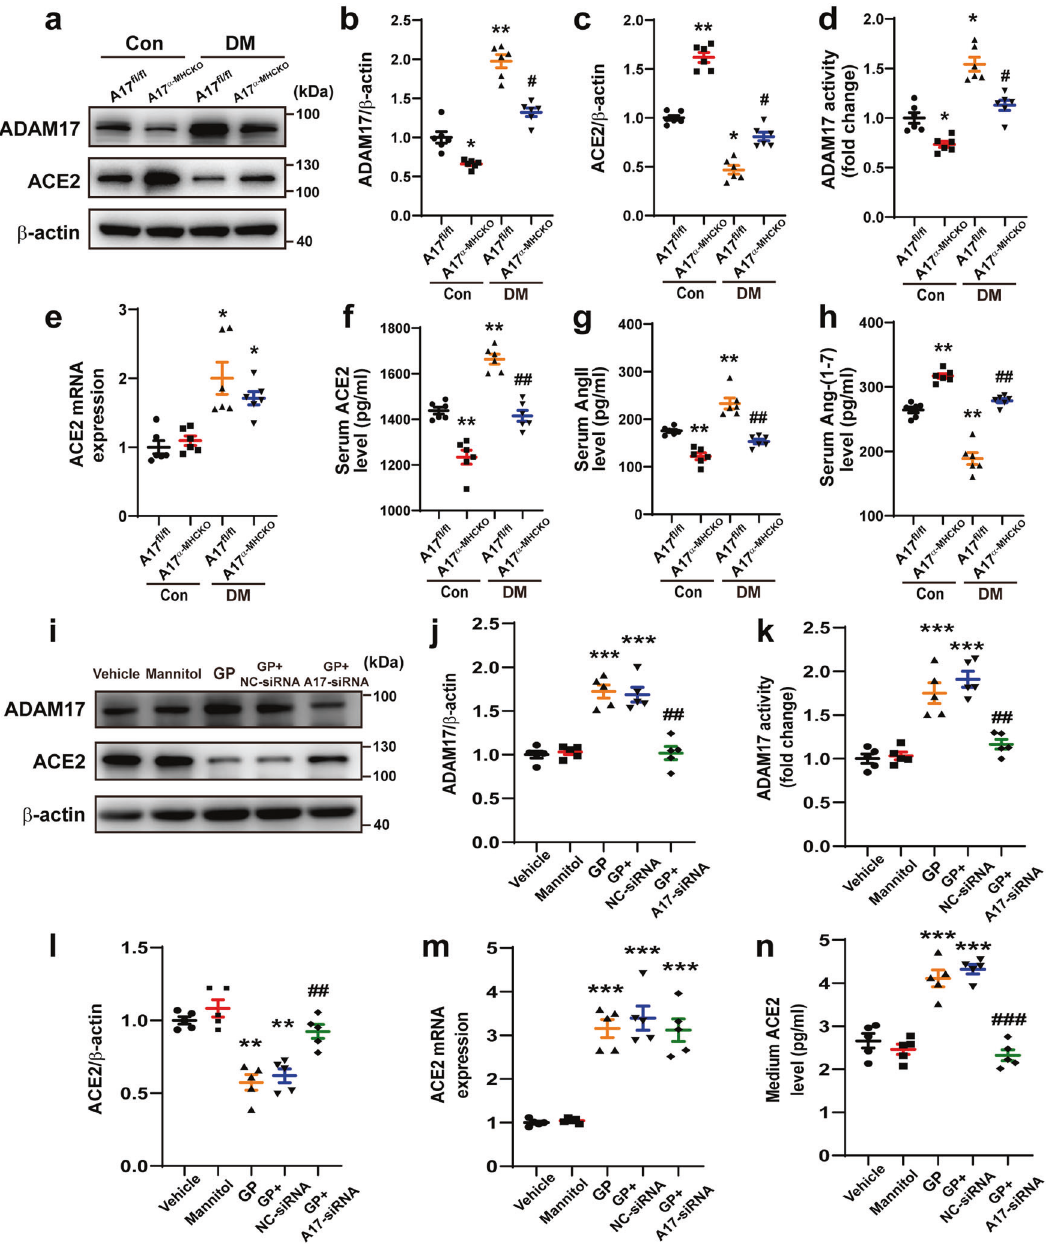
Fig. 4 Serum levels of ACE2, Ang II, and Ang-(1 – 7) in mice and expression of ADAM17 and ACE2 in the myocardium of mice and in differentiated H9c2 cells. a Representative Western blot images of ADAM17 and ACE2 protein expression in the myocardium of four groups of mice. b , c Quantitative analyses of ADAM17 and ACE2 expression in the myocardium of mice, n = 6. d Quantitative analysis of ADAM17 activity in the myocardium of mice, n = 6. e Quantitative analysis of ACE2 mRNA expression in the myocardium of mice, n = 6. f – h Quantitative analysis of serum levels of ACE2, Ang II, and Ang-(1 – 7) in mice, n = 6. Data were shown as mean ± SEM. * P < 0.05, ** P < 0.01 vs. the A17 fl / fl control group; # P < 0.05, ## P < 0.01 vs. the A17 fl / fl DM group. i , j and l Representative Western blot images and quantitative analysis of ADAM17 and ACE2 protein expression in fi ve groups of differentiated H9c2 cells treated with vehicle, mannitol, GP, GP + NC-siRNA and GP + ADAM17- siRNA, respectively. Mean values were derived from fi ve independent experiments. k Quantitative analysis of ADAM17 activity in fi ve groups of differentiated H9c2 cells treated as above. m , n Quantitative analysis of ACE2 mRNA level and ACE2 expression in the medium in fi ve groups of differentiated H9c2 cells treated as above. Mean values were derived from fi ve independent experiments. Data were shown as mean ± SEM. ** P < 0.01, *** P < 0.001 vs. the vehicle group; ## P < 0.01, ### P < 0.001 vs. the GP + NC-siRNA group. To further assess whether ACE2 was connected with the effect was not affected by ADAM17-siRNA treatment (Fig. 4m), a fi nding of ADAM17 on apoptotic response, the related indicators of in line with our in vivo results. The increased level of ACE2 in the apoptosis were measured in differentiated H9c2 cells and NRCMs. culture medium after GP treatment as compared with the The Bax/Bcl2 ratio and cleaved caspase-3 expression levels were mannitol group was substantially suppressed with ADAM17- increased by GP treatment, which was further elevated in the siRNA treatment (Fig. 4n), indicating that ADAM17 may cleave GP + ACE2-siRNA group (Fig. 3g – i). These results were opposite to ACE2 into the medium. Signal Transduction and Targeted Therapy (2022)